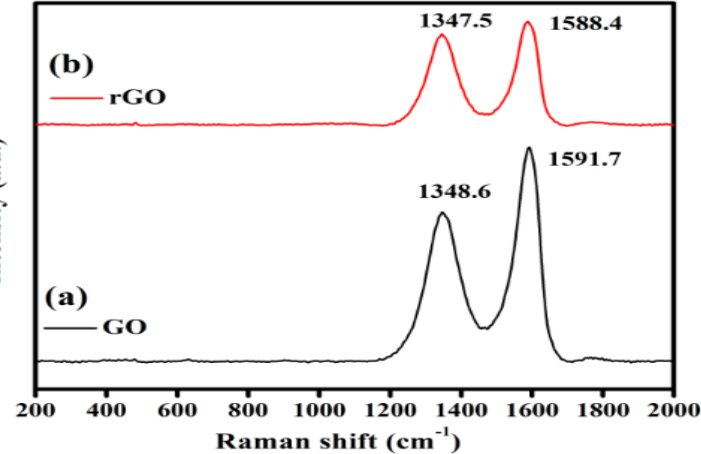
Figure 2. Raman spectra of GO and rGO. The GO and reduction of GO can be identified in Raman spectra by the changes in relative intensity of the two major peaks of the D and G band.